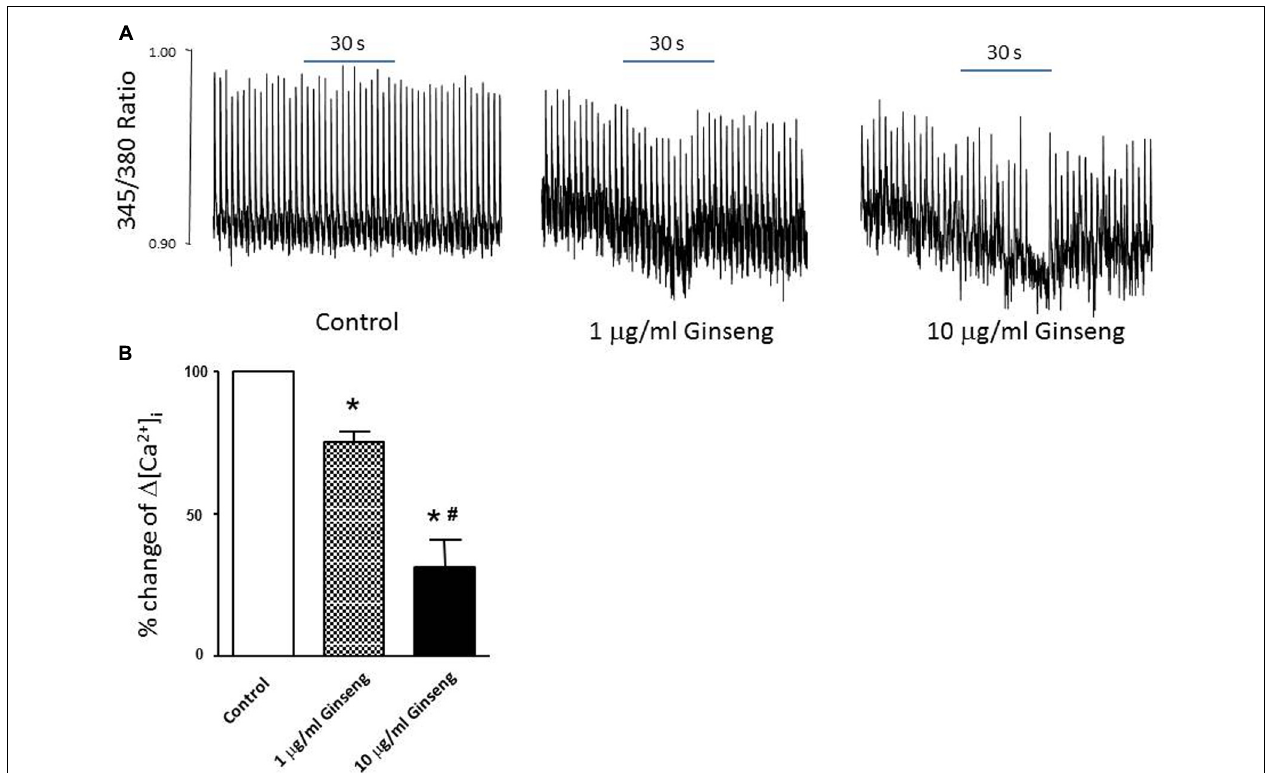
and Methods for details). (B) Concentration-dependent response of ginseng on intracellular Ca 2 + transient changes. (cid:2) [Ca 2 + ] i expressed as the percentage change of control. Data are presented as mean ± SE. * p < 0.05 compared to control; # p < 0.05 compared to 1 μ g/ml ginseng dose. n = 5 in each